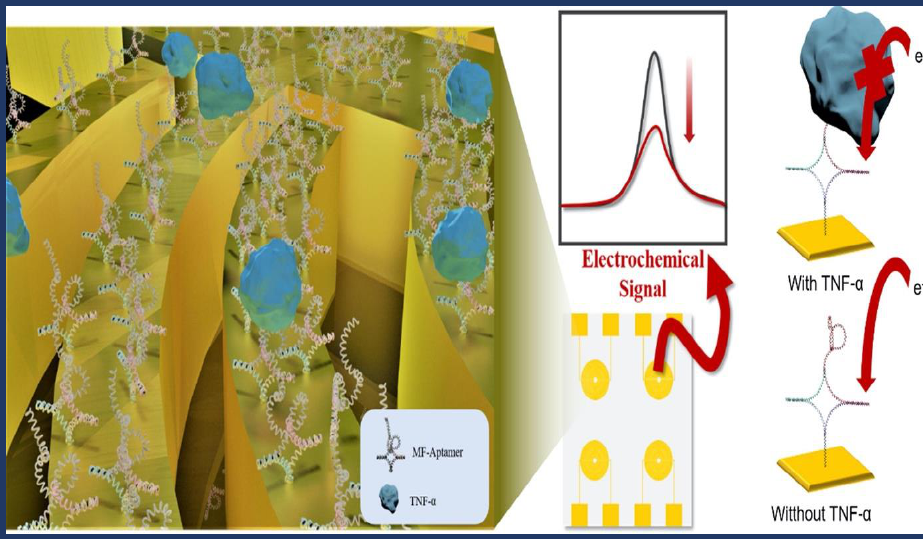
Figure 2. Schematic representation of fabricated tumor necrosis factor- α ( TNF- α ) sensing biosensor. CV was carried out for 10 cycles within the potential range of − 0.4 V to 0.4 V with a scan rate of 0.1 V/s. Reprinted from Ref. [38] with permission from Elsevier.